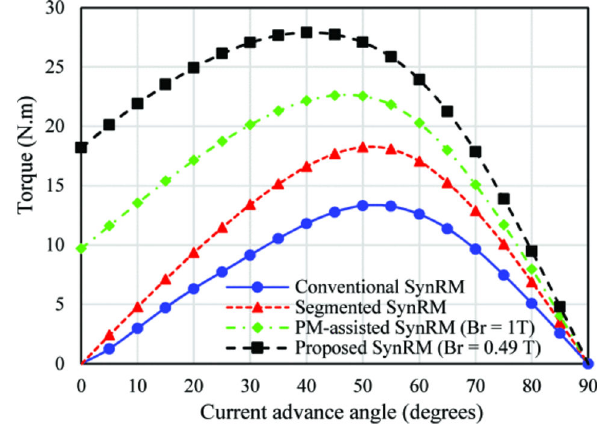
Figure 13. Comparison of torque characteristics